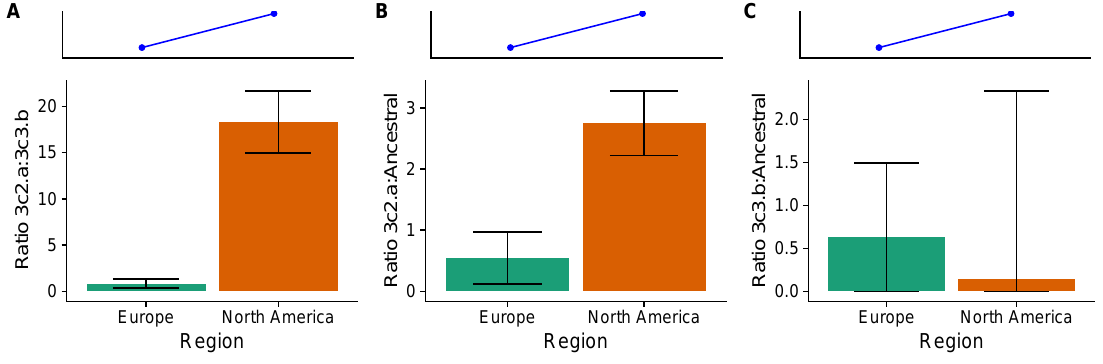
Figure 5. Ratios of ( A ) 3c2.A to 3c3.B, ( B ) 3c2.A to ancestral (3c and 3c3) viruses, and ( C ) 3c3.B to ancestral viruses during the 2014–2015 season in the United States and Europe. The blue lines and points show the expected direction (but not magnitude) of the spatial difference in lineage ratios based on ( A ) clade-specific VEs or ( B , C ) antigenic differences between clades. Error bars indicate 95% multinomial confidence intervals. Complete clade frequencies are shown in Figure